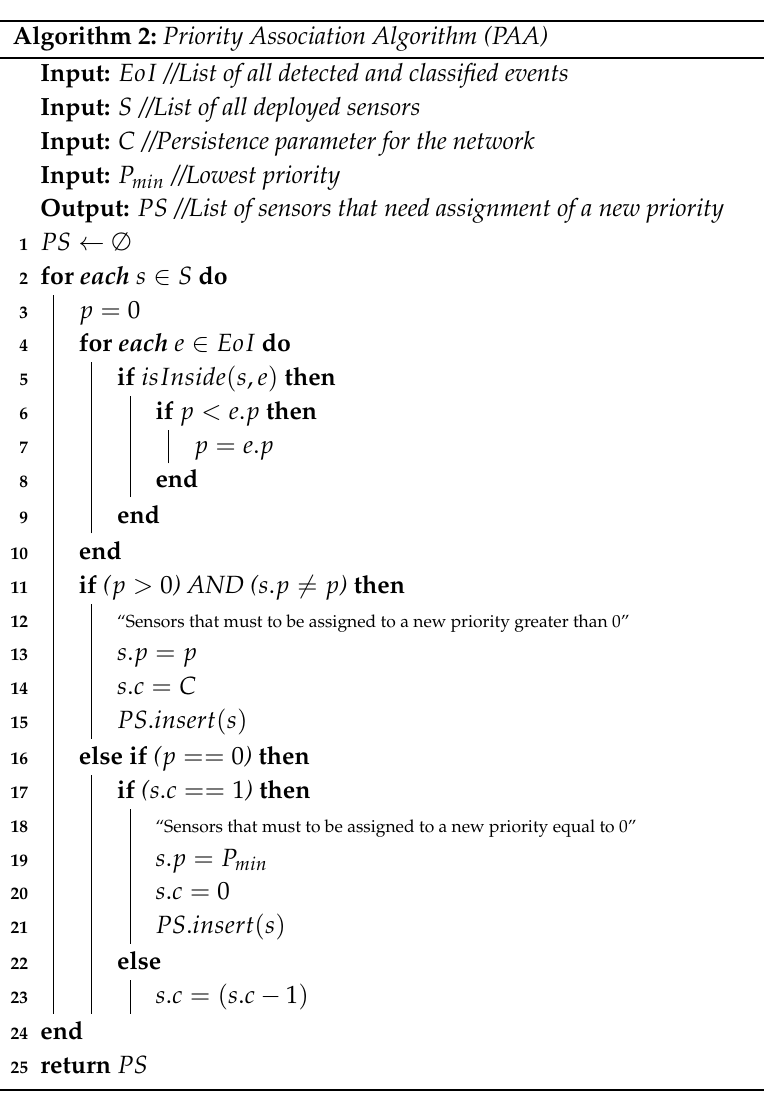
Algorithm 2: Priority Association Algorithm